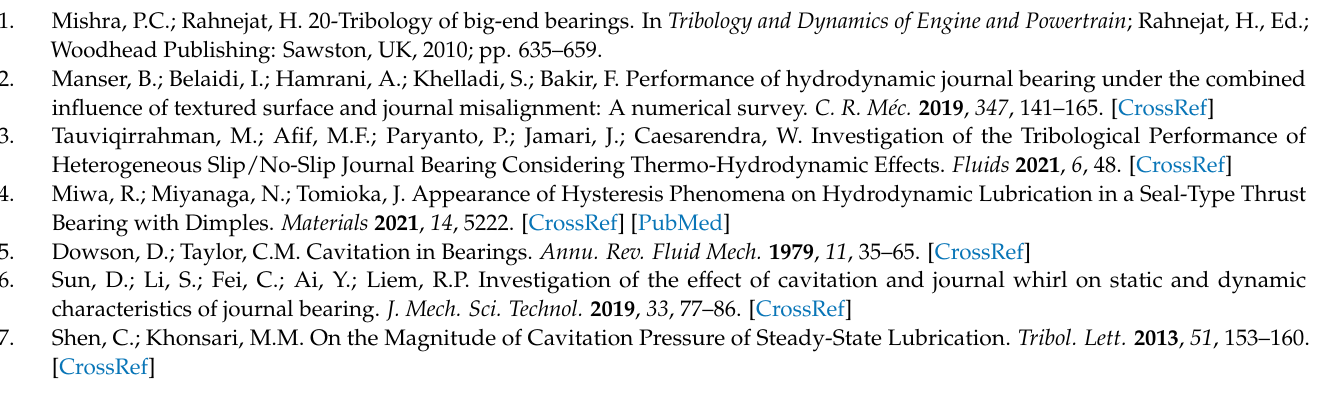
Figure 12. Comparison of pressure distribution between different results for y = 1.5 mm.